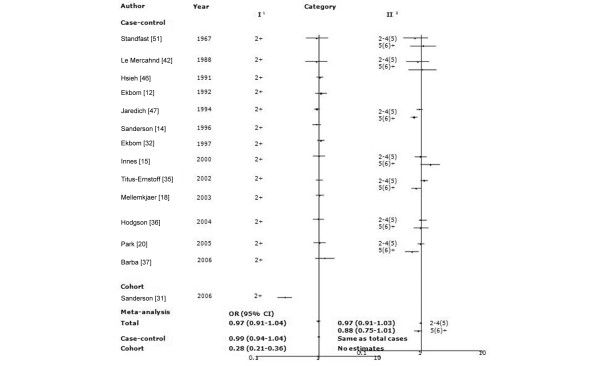
Meta-analysis of the association between birth order and risk for breast cancer. The tests for homogeneity and for publication bias in the studies analyzed are as follows. Category I (birth order 2+) versus reference (birth order 1): Q = 87.79 (13 degrees of freedom), P < 0.01; Begg test, P = 0.44; Egger test, P = 0.46. Category II (birth order 5+ and 2 to 4) versus reference: Q = 4.56 (6 degrees of freedom), P = 0.60; Begg test, P = 0.37; Egger test, P = 0.44. Category II (birth order ≥6, 2 to 5) versus reference: Q = 14.42 (6 degrees of freedom), P = 0.60; Begg test, P = 0.37; Egger test, P = 0.44. 1Category I of birth order was 2+ vs 1. 2Category II of birth order was composed of two conditions: 5+ and 2 to 4; and ≥6 and 2 to 5 vs 1. 3We used adjusted odds ratios (ORs) for meta-analysis because the numbers of cases and controls were not represented in the original article. CI, confidence interval.